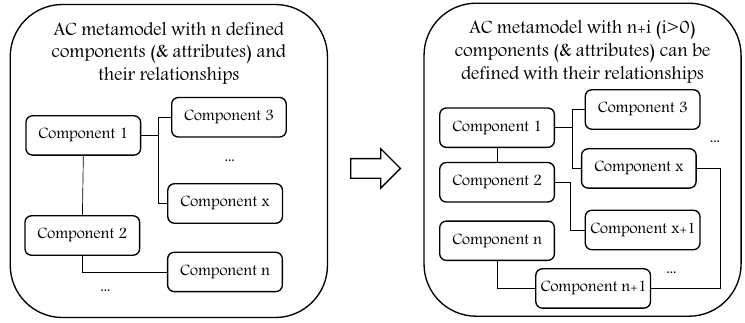
Figure 8. The concept of dynamic AC metamodel.